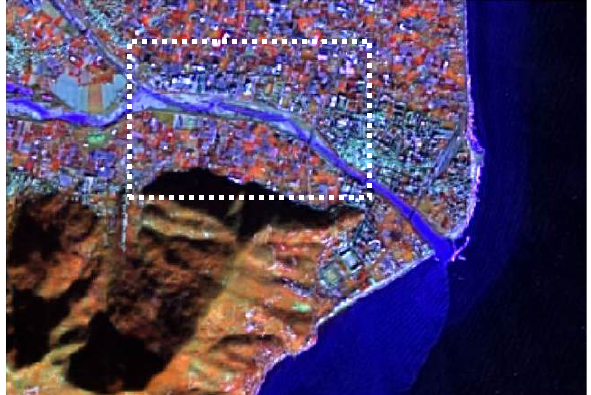
Figure 3. A close-up on the town of Albenga and delta of Centa River seen in SWIR – NIR – red pseudo colour composite on Nov 29 th 2016. Visual interpretation allows us to identify some significant mud deposit, probably due to the recent flood event (area within the white square).